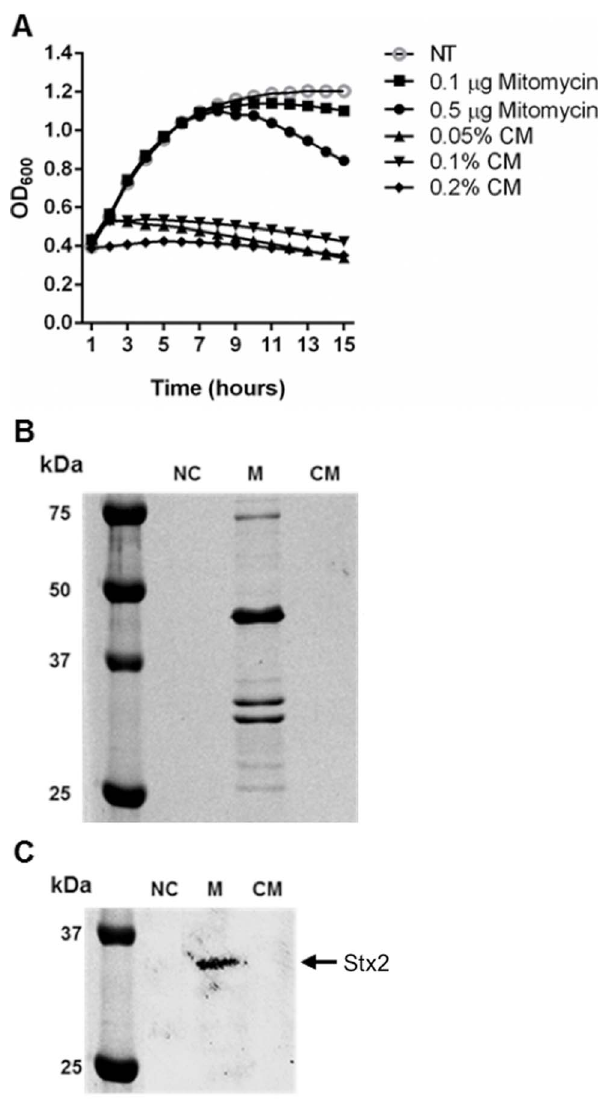
Figure 6. Chitosan microparticles do not induce bacterial phage and Shiga-toxin expression. (A) Phage induction was measured by a reduction of the OD 600 of the bacterial culture with mitomycin C or CM at different concentrations. (B) SDS-PAGE analysis of phage proteins. Phage particles were obtained by PEG precipitation of cell lysate from mitomicin C-treated and CM-treated cultures. Phage proteins are visualized by Coomassie blue staining. (C) Shiga-toxin expression by CM treatment. E. coli O157:H7 strain was grown with CM and cell lysates were collected. Shiga-toxin expression was analyzed by Western blotting using antibody specific to Shiga-toxin. NC (negative control; without treatment), M (mitomycin C, 1 m g/ml), CM (chitosan microparticles,